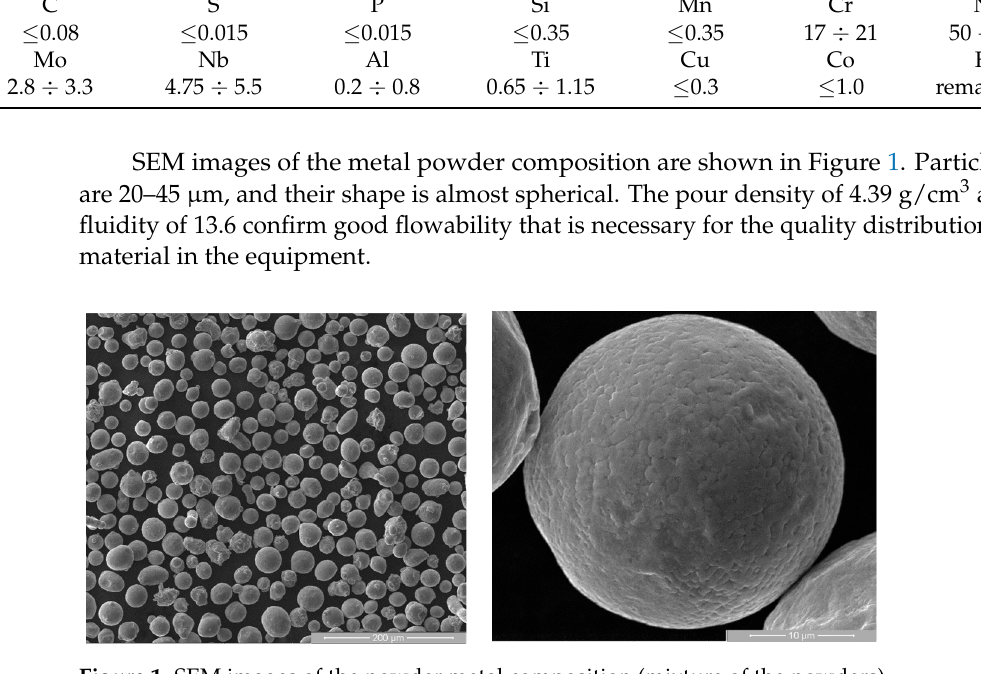
Figure 1. SEM images of the powder metal composition (mixture of the